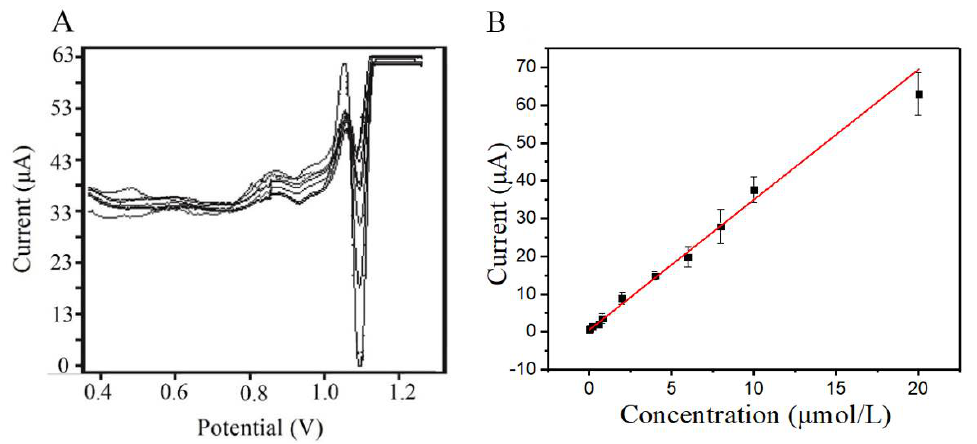
Figure 8. ( A ) SDLSV of different concentrations of tartrazine on the TiO 2 –ErGO–GCE; linear curve representing the relationship between oxidation peak current and concentrations of tartrazine in the range of 2.0 × 10 −8 –2.0 × 10 −5 mol/L ( B ).